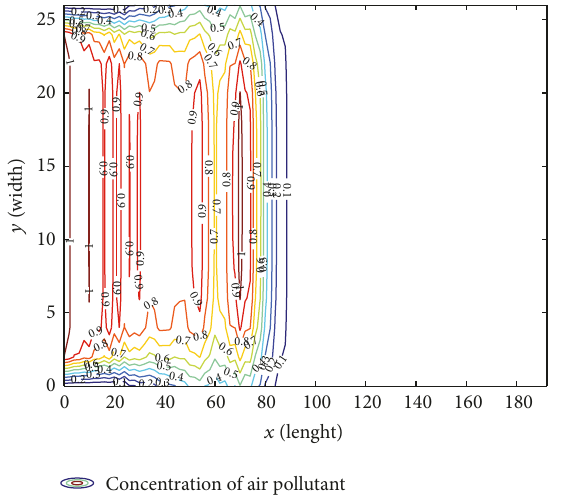
Figure 12: Contour plot of concentration of air pollutant levels for 𝑅 = 0.0 01sin (𝑥𝑡) sec −1 .